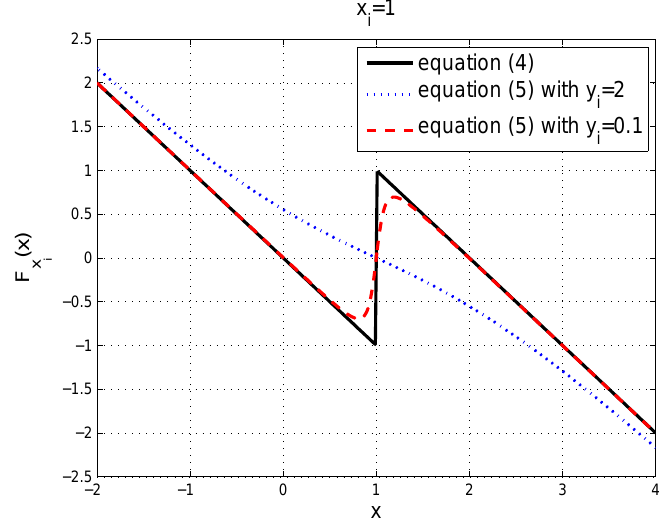
( x ) for Equations (4) and (5) with x x i